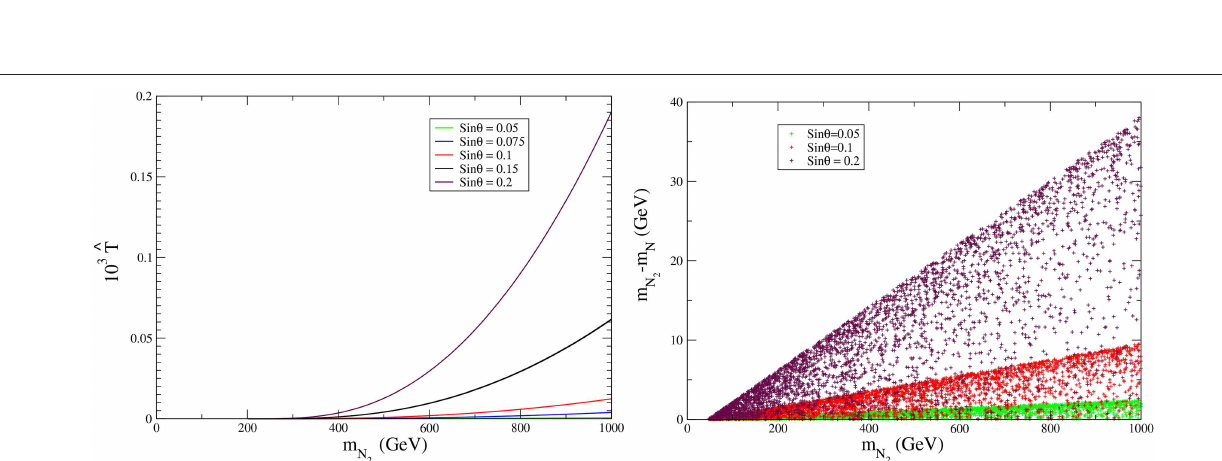
FIGURE 15 | In the left panel, ˆ S is shown as a function of m N sin θ 0.15 (Black color), and sin θ = sin θ 0.1 (Red color), and sin θ =